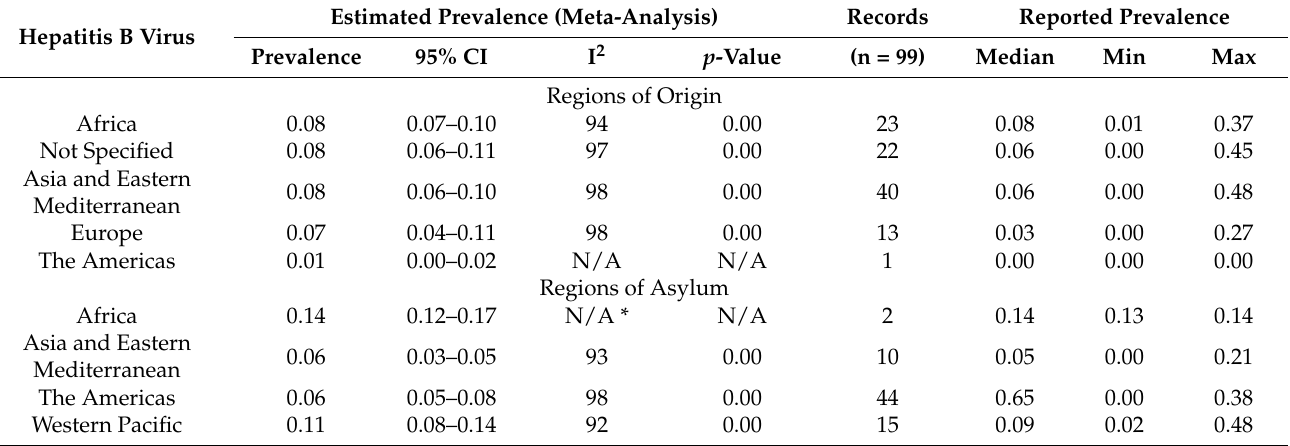
* Not available due to low number of records.